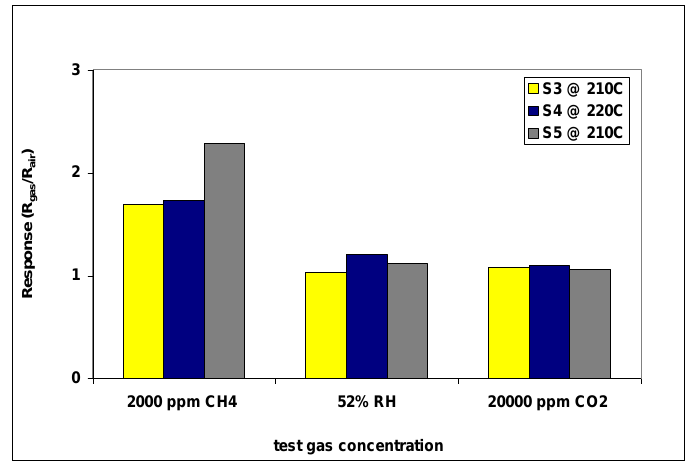
Figure 6. S3 , S4 , S5 cross-response for different tested target gas concentrations.